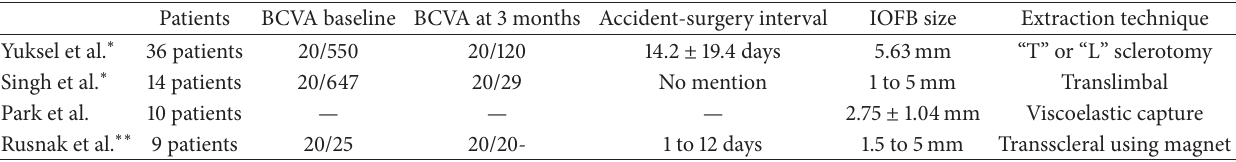
Table 1: Different IOFB extraction